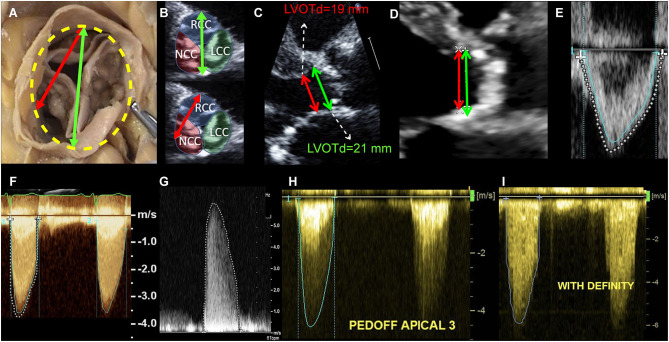
Echocardiographic measurement pitfalls and how to avoid them. LVOT diameter must be measured at its maximal dimension, which generally corresponds to the bisection between the right coronary cusp hinge point anteriorly and the interleaflet triangle between the left and non-coronary cusps posteriorly (A,B). LVOTd must be measured at the annulus and not 5–10 mm below, as this leads to significant underestimation of AVA and SV (C). In this case, measuring 5 mm below the annulus (as recommended in guidelines) lead to an LVOT area of 2.83 cm2, as compared to an area of 3.46 cm2 when measured at the annulus (18% underestimation, therefore leading to significant underestimation of SV and AVA). In case of LVOT ectopic calcification, if the plane that bisects the largest diameter cannot exclude the calcium, LVOT diameter measurement should include the calcium in the measurement (D). LVOT velocity-time integral should be measured at the modal velocity (the densest line of the Pulse Wave Doppler) since flow at the LVOT is laminar (E: blue trace represents the modal velocity whereas the dashed white line overestimates LVOT VTI). For an accurate measurement of the transaortic jet velocity, tracing should be done at peak velocities but excluding fine linear signals (F: green trace represents the correct measurement, whereas the dashed white line overestimates aortic valve VTI by including linear signals). It is paramount that the Doppler beam is optimally aligned parallel to the stenotic aortic jet. Therefore, a meticulous search of the highest transvalvular velocity is mandatory. This requires a comprehensive Doppler study that is not only limited to the apical window but also includes right parasternal, suprasternal, and sometimes subcostal approaches using a small, dedicated CW Doppler transducer (pencil probe or Pedoff transducer) (G,H). Finally, the use of ultrasound enhancing agents (i.e., contrast echocardiography as with Definity®) might lead to overestimation of transvalvular velocities and gradients and therefore caution should be taken (I).